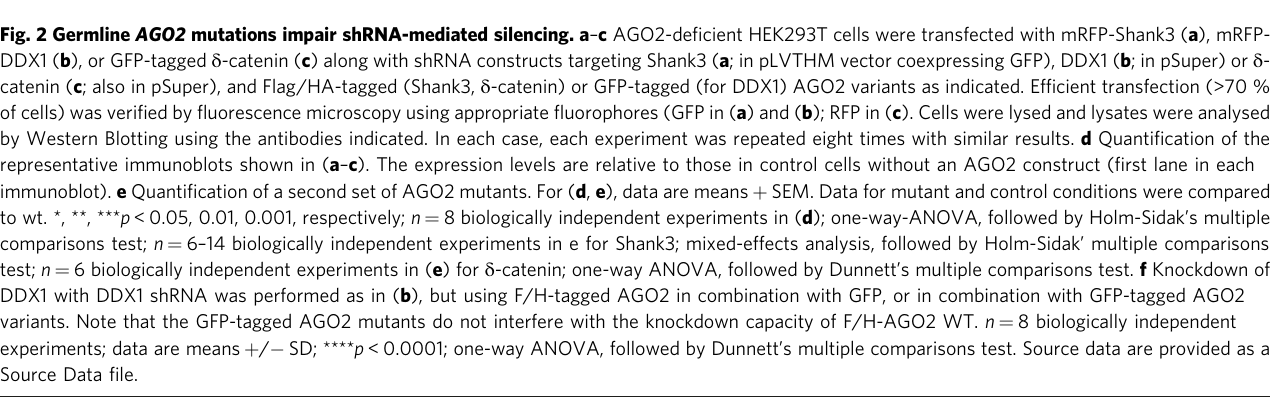
Fig. 2 Germline AGO2 mutations impair shRNA-mediated silencing. a – c AGO2-de fi cient HEK293T cells were transfected with mRFP-Shank3 ( a ), mRFP- DDX1 ( b ), or GFP-tagged δ -catenin ( c ) along with shRNA constructs targeting Shank3 ( a ; in pLVTHM vector coexpressing GFP), DDX1 ( b ; in pSuper) or δ - catenin ( c ; also in pSuper), and Flag/HA-tagged (Shank3, δ -catenin) or GFP-tagged (for DDX1) AGO2 variants as indicated. Ef fi cient transfection (>70